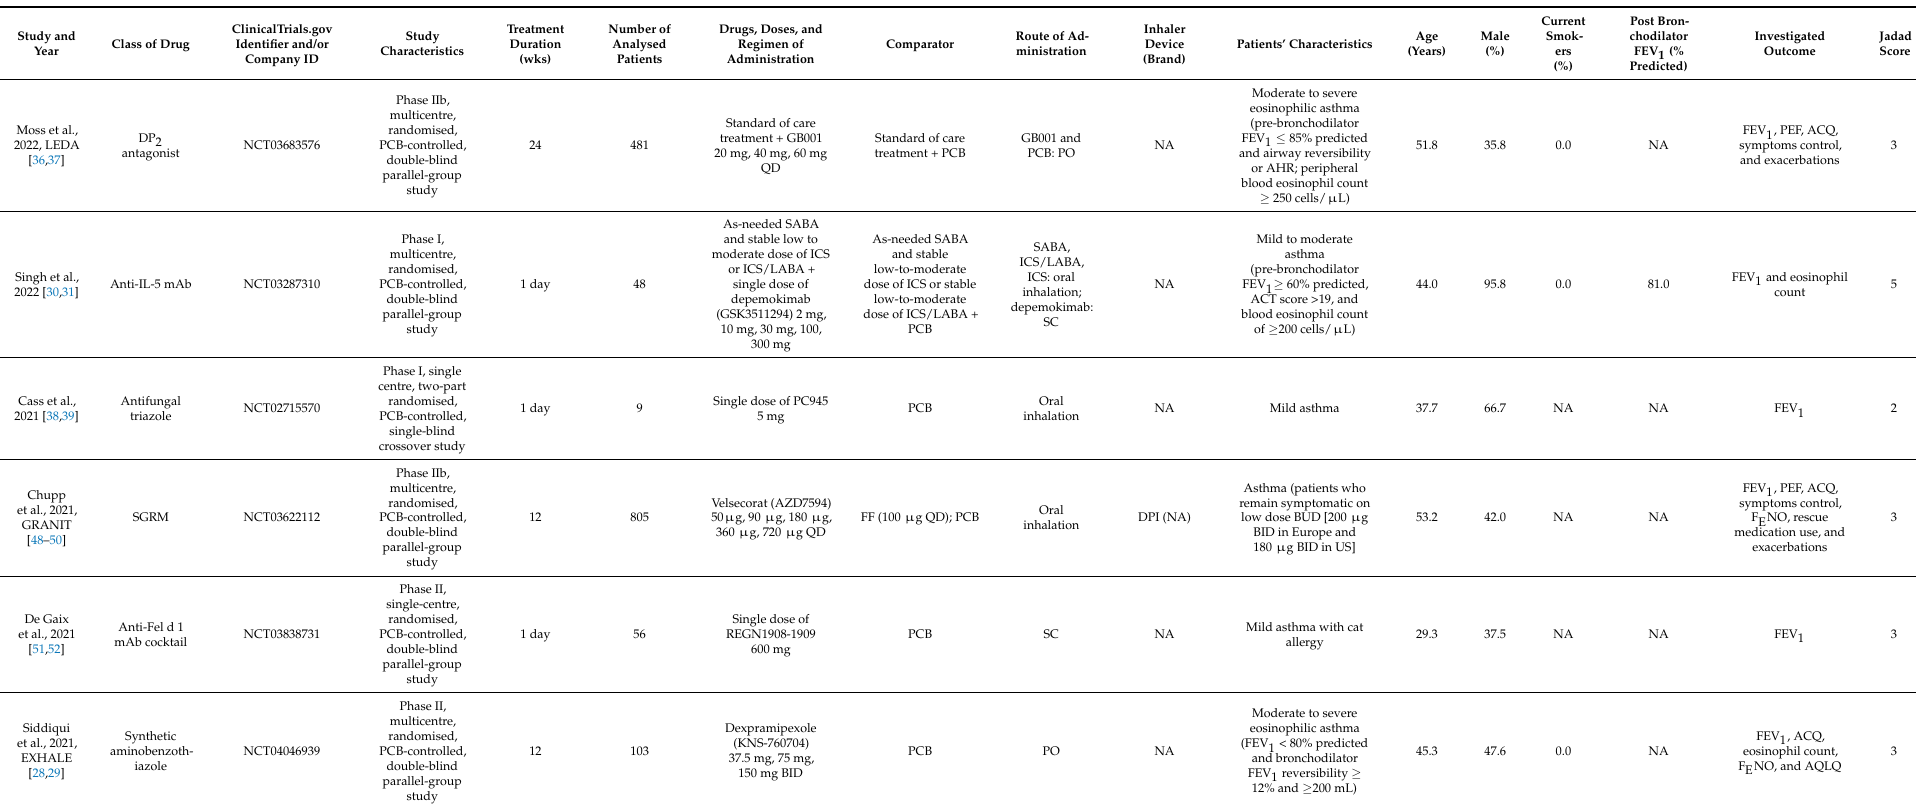
Table 1. Characteristics of the studies included in the systematic